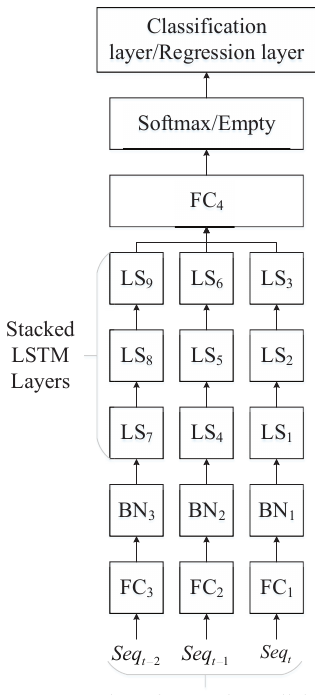
Figure 2. The parallel-stacked LSTM networks for intention